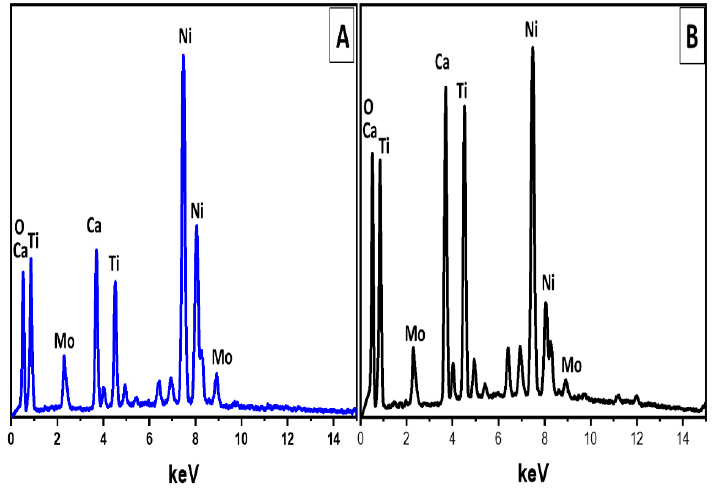
Figure 5. Energy-dispersive X-ray spectroscopy (EDXS) spectra of NiMo / CaTiO 3 catalysts containing di ff erent CaTiO 3 content: ( A ) NMC412 and ( B ) different CaTiO 3 content: ( A ) NMC412 and ( B ) NMC414.